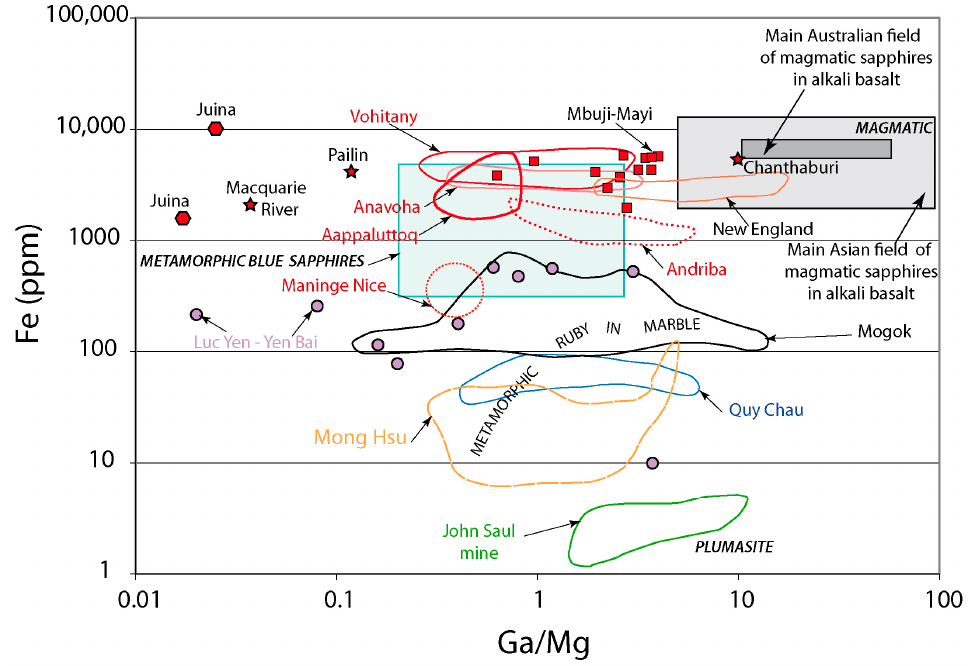
Figure 19. Fe (ppm) versus Ga / Mg discrimination diagram for ruby (this work; modified from [69]), showing the variation of Fe content for some rubies relative to their geological environments. The boxes for magmatic sapphire related to alkali basalts are reported for comparison with the plot of Pailin sapphire in Cambodia (data from [72,82]) as well as the box of metamorphic sapphires (drawn with the range of values defined in the tables of [70]). The following di ff erent types of ruby and / or their chemical fields are shown: (1) the chemical domain of rubies associated with M-UMR (red domains) from (i) Madagascar [72] with the occurrences of Vohitany (analysis, n = 25), Anavoha ( n = 6), and Andriba ( n = 6); (ii) Greenland and the chemical domain of Aappaluttoq ruby deposit ( n = 24, data from [83]); (iii) Mozambique (Montepuez mining district) with the colluvial deposit of Maninge Nice from (Pardieu, unpublished data); (2) inclusions of ruby in diamonds from Juina in Brazil (red hexagon) [43]; (3) xenocrysts of ruby from the Mbuji-Mayi kimberlite in the Democratic Republic of Congo (red square) [84]; (4) xenocrysts of rubies in alluvial of alkali basalts such as Pailin, Chantaburi-Trat, and Macquarie River and New England in Australia (red star) [82,85,86]; (5) rubies in marble from Luc Yen-Yen Bai represented by single measurements (violet circle) and Quy Chau (blue domain) in Vietnam [57,66], Mogok (black domain) [87], and Mong Hsu (orange domain) [88]; and (6) rubies from the former John Saul (now Rockland) mine in Kenya (green domain) from desilicated pegmatites (Giuliani et al., unpublished data). These rubies show high variations in Fe, which permits discrimination of their geological type; this is characterized by a decrease of Fe from rubies in M-UMR to marble and metasomatic rocks (plumasite and shear-zones). The Ga / Mg ratio of rubies from M-UMR is di ff erent from magmatic sapphires but is within the range of values of metamorphic sapphires as defined by [69]. The domains represent the distribution of several spot analyses. The others analyses are the average values of punctual measurements.